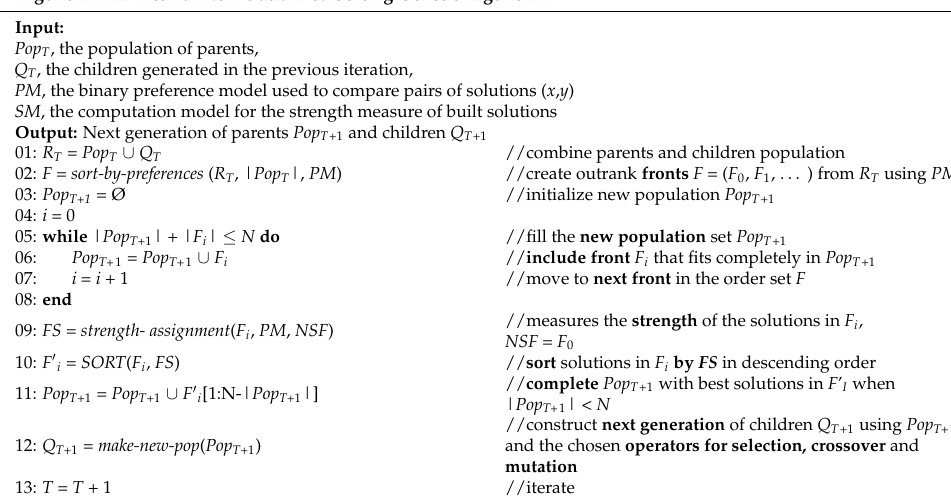
Algorithm A1. Interval Non-Outranked Sorting Genetic Algorithm